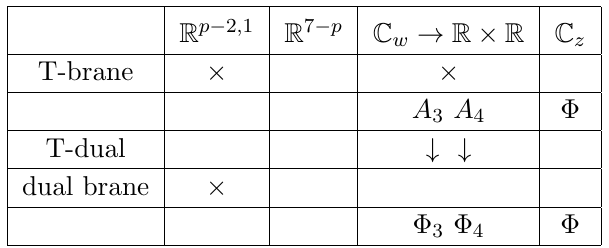
Table 1 . Illustration of the two